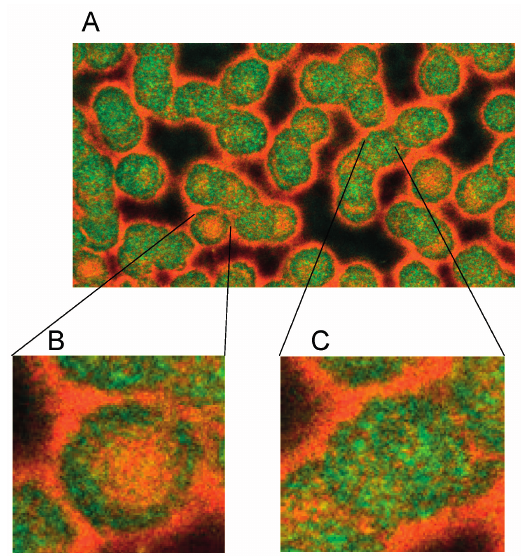
Figure 5. Merger of red (actin) and green (spectrin) channels of the confocal microscope showing erythrocytes after examination in autologous plasma ( A – C ) with details of magnified single ( B ) or aggregated erythrocytes ( C ) (reprinted from reference [20], Copyright 2013, with permission from IOS Press) ( A ) primary magnification 1:63; zoom factor 2.5; ( B ) primary magnification 1:63; zoom factor 5; ( C ) primary magnification 1:63; zoom factor 5.